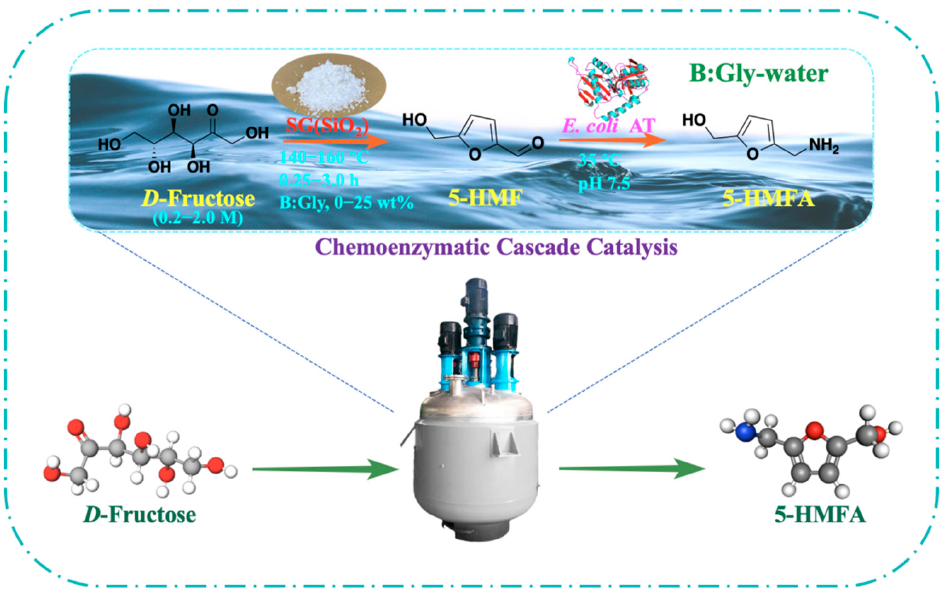
Figure 1. A hybrid synthetic route for the chemoenzymatic sustainable synthesis of 5-HMFA from D -fructose in betaine-based DESs–water medium.